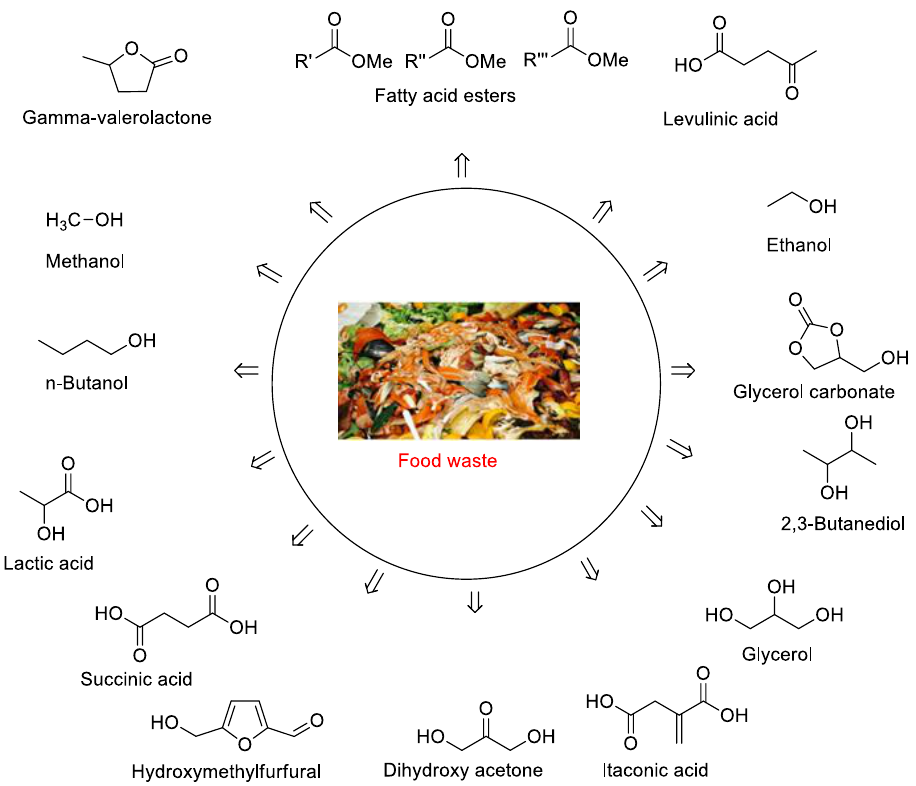
Figure 8. Chemical structures of fuels and chemical building blocks derived from food waste.